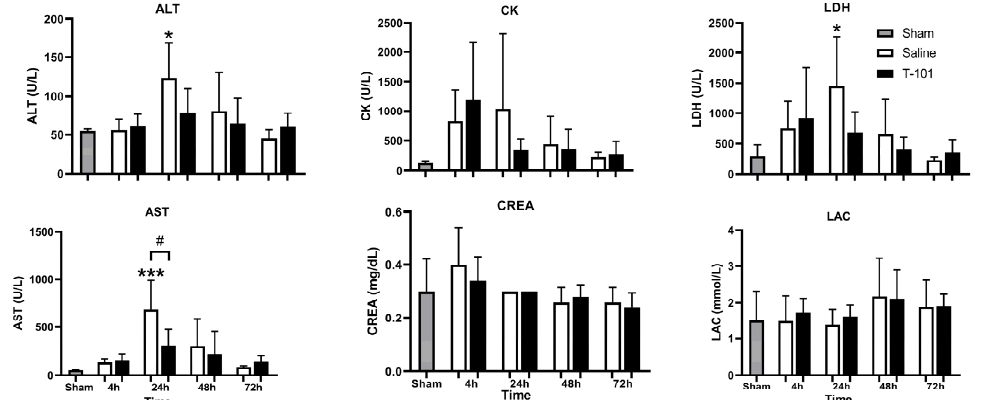
Figure 2. Blood chemistry plasma markers: alanine aminotransferase (ALT), aspartate aminotrans- ferase (AST), creatine kinase (CK), creatinine (CREA), lactic acid dehydrogenase (LDH), and lactate (LAC). Data are plotted as the mean ± standard deviation. Significant differences for the control resuscitative fluid and T-101 groups when compared to the sham group are noted by an asterisk (* p < 0.05, *** p < 0.0005). Significant difference between the control resuscitative fluid and T-101 groups is noted by # ( p < 0.05). Data compared by one-way ANOVA and the Bonferroni multiple comparison test. The analyzed groups included five animals (n = 5) per timepoint for the control and T-101 resuscitative fluid groups; five animals were analyzed in the sham group.